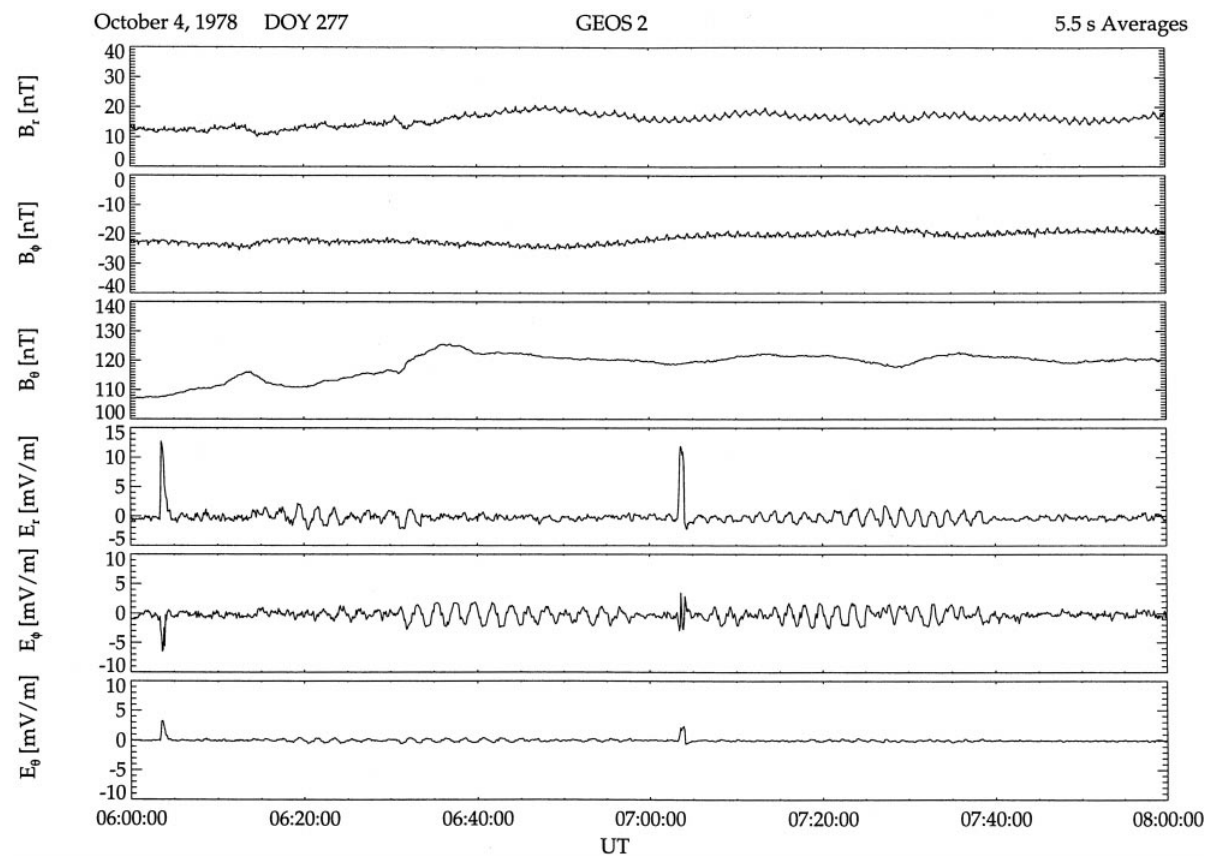
Fig. 4. Magnetic and electric field measurements made onboard the GEOS-2 satellite in the time interval October 4, 1978, 0600–0800 UT. The observations are represented in a dipole coordinate